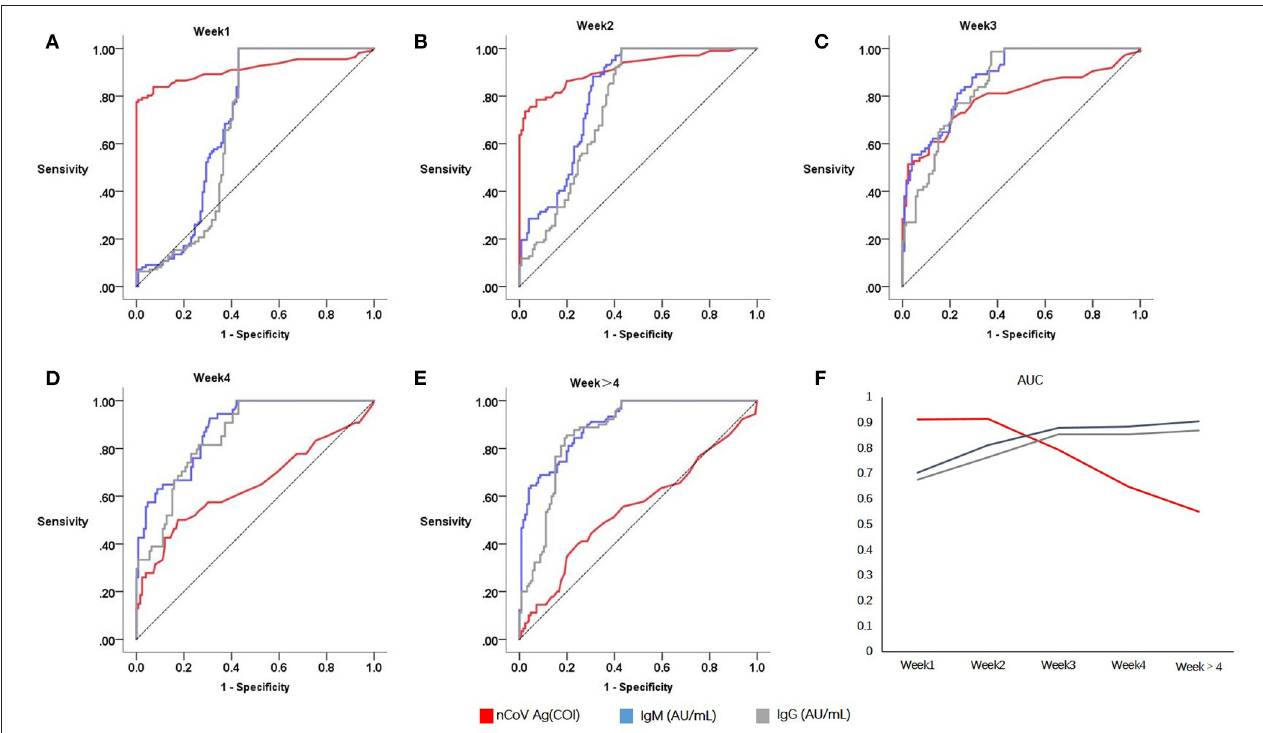
FIGURE 2 | Sensitivities and specificities analysis of serological testing for COVID-19 diagnosis. Red denotes serum antigen, blue and grey denotes specific antibodies IgM and IgG, respectively. Receiver operating curves of Week1 (A) , Week2 (B) , Week3 (C) , Week4 (D) , Week > 4 (E) ; Area under curves relate to the time of onset (F) .